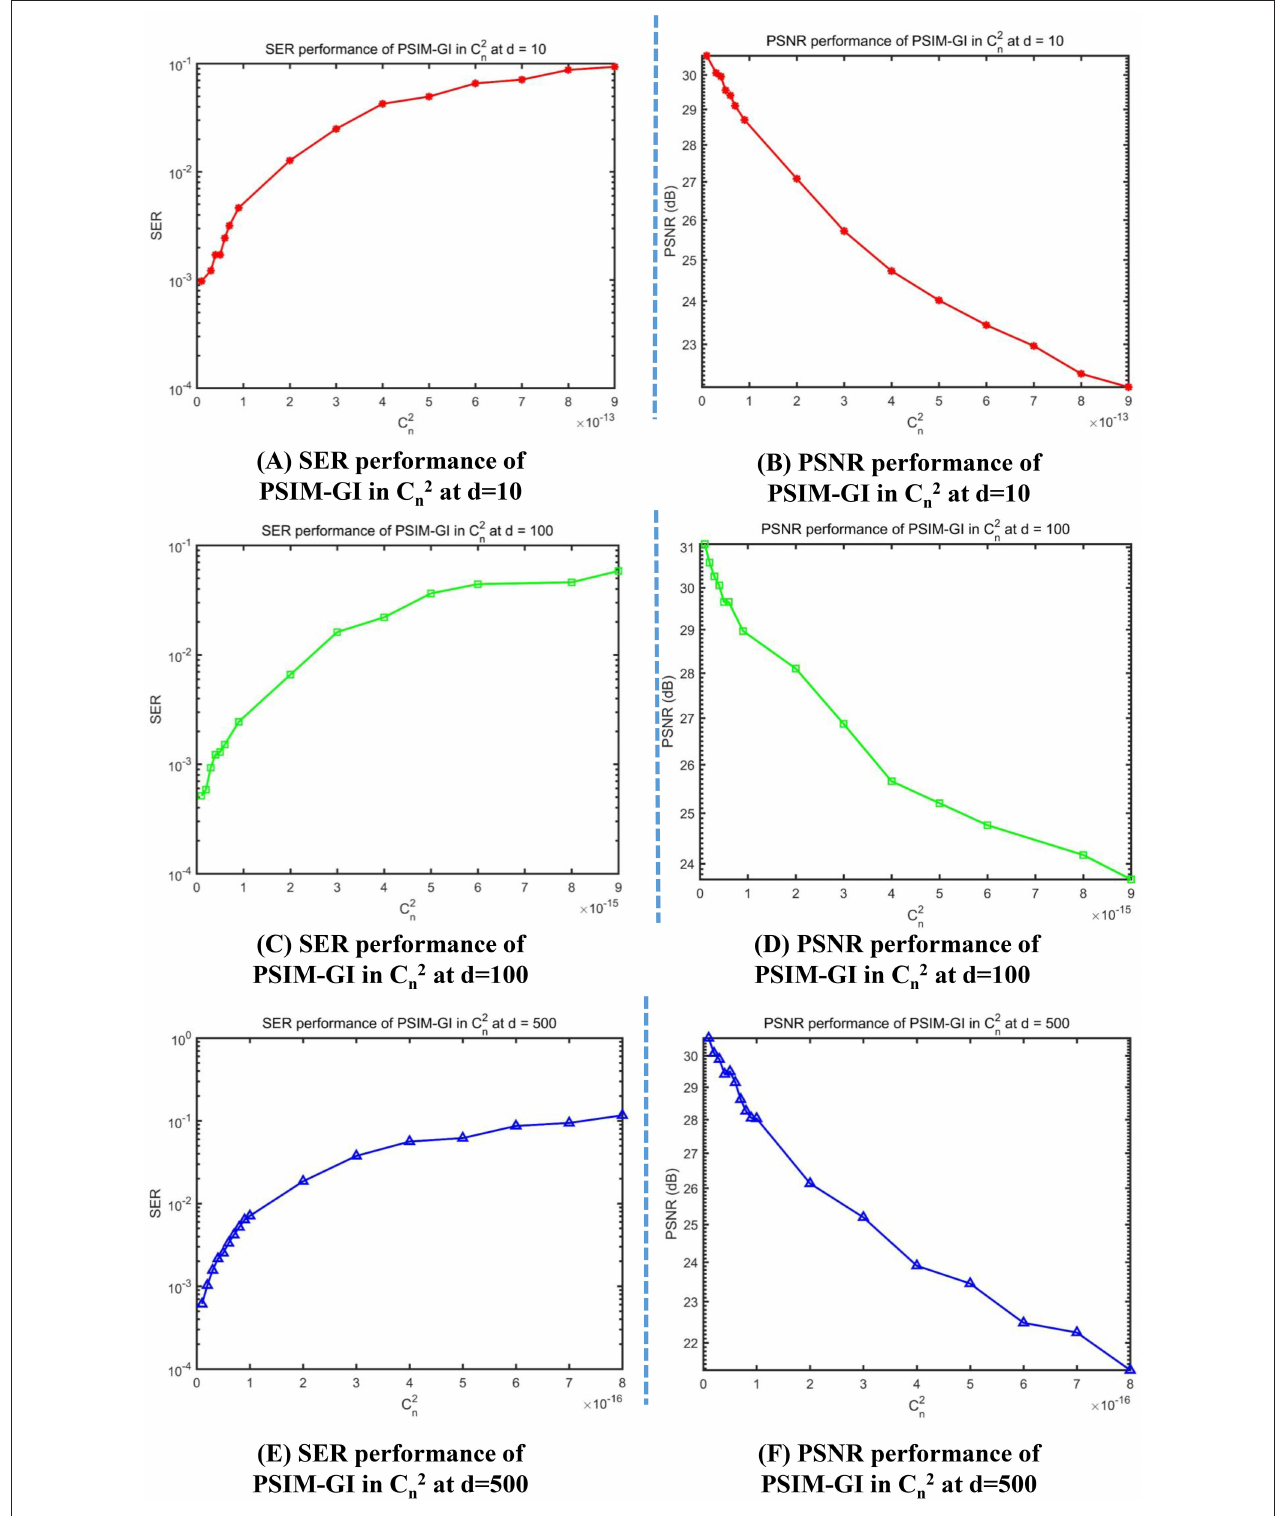
FIGURE 11 | Symbol-error rate (SER) and peak signal-to-noise ratio (PSNR) curves for different values of the refractive-index structure parameter. (A) SER performance of PSIM-GI in C 2 n at d performance of PSIM-GI in C 2 n at d